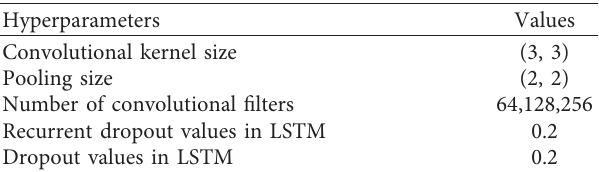
Table 1: Some parameter values in CRNN